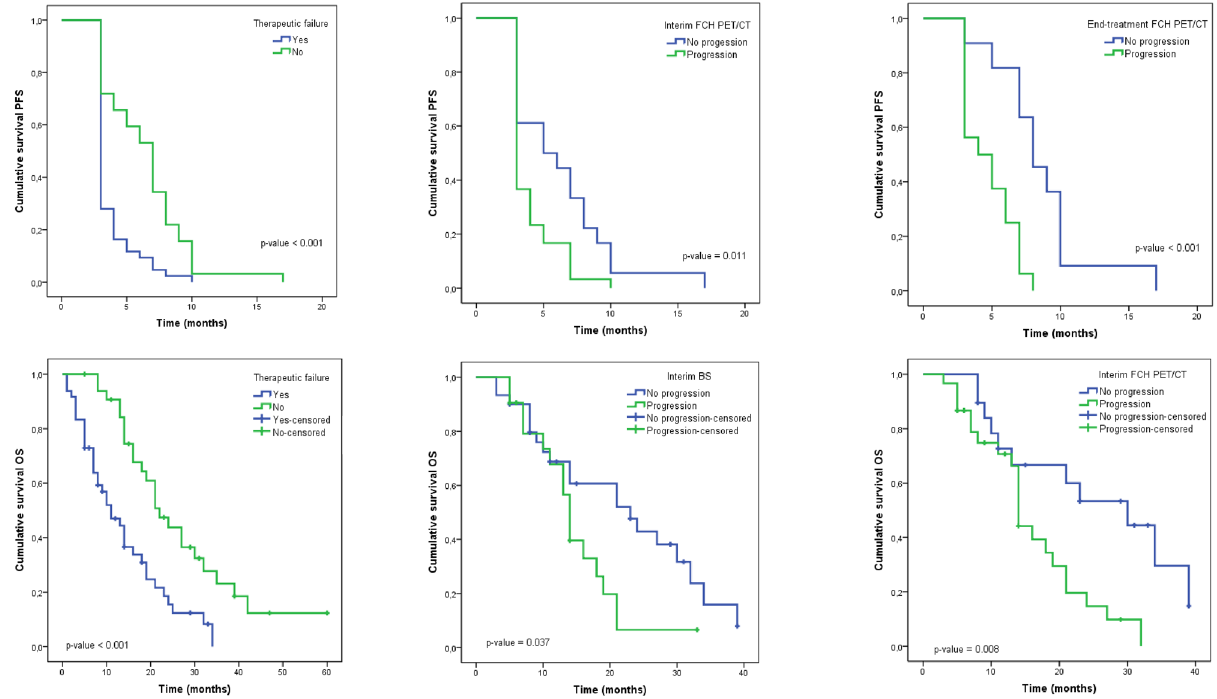
Figure 1. Upper row: Log Rank results of therapeutic failure ( A ), interim FCH PET/CT ( B ) and end-treatment FCH PET/CT ( C ) in their associations with PFS. Lower row: Log Rank results of therapeutic failure ( D ), interim BS ( E ) and interim FCH PET/CT ( F ) in their associations with